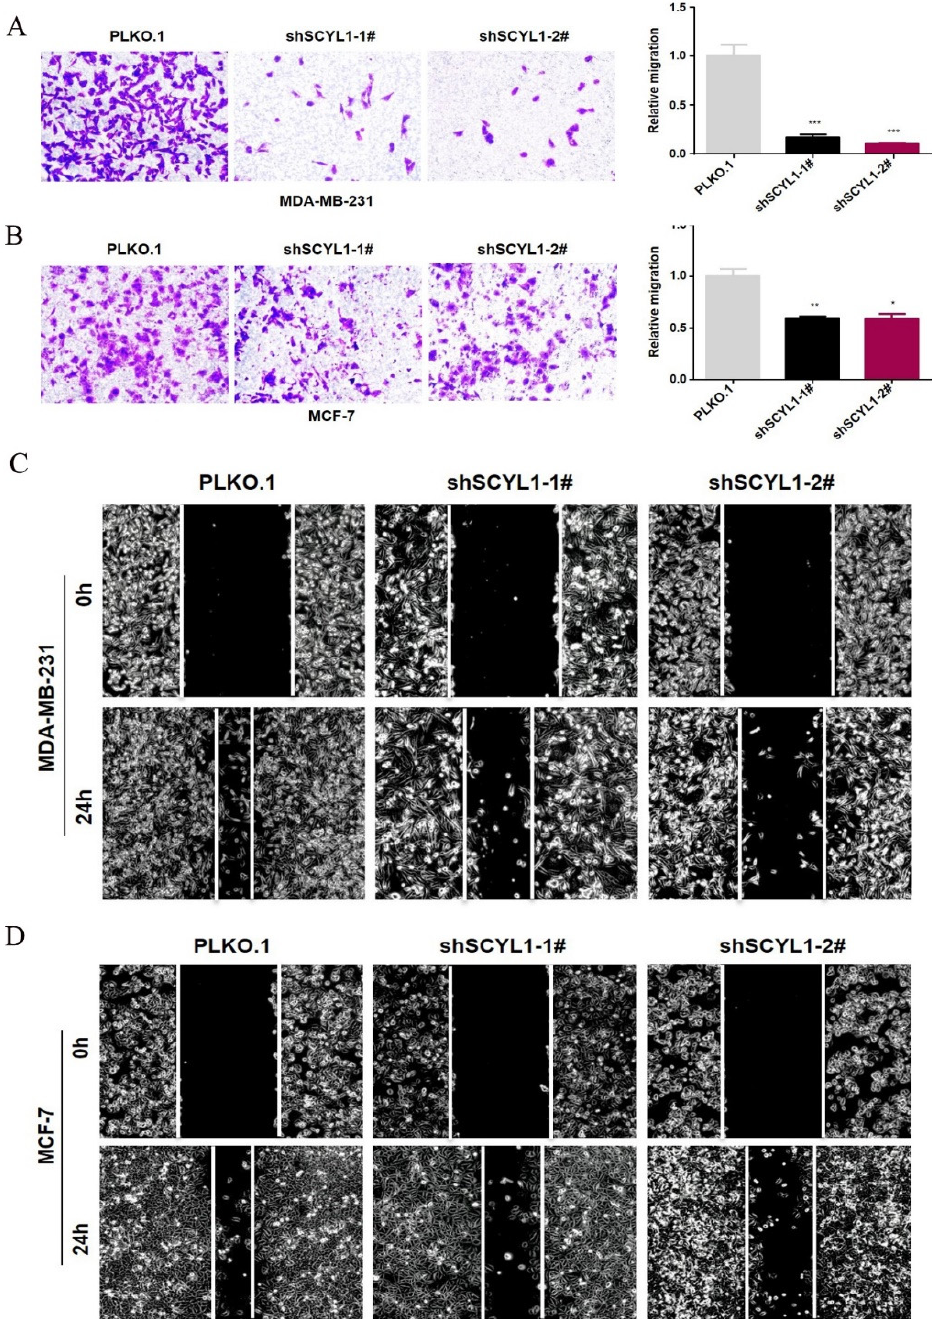
Figure 5. Silencing SCYL1 inhibits the migration of BC cells. ( A , B ) The effect of knockdown of SCYL1 on cell migration determined by the transwell assay; statistical results of invaded cells in three randomly selected fields in each sample; original magnifications ×200. ( C , D ) The wound healing assay of the effect of SCYL1 knockdown on the breast cancer cell migration; original magnifications ×100. *: p -value < 0.05; **: p -value < 0.01; ***: p -value < 0.001.